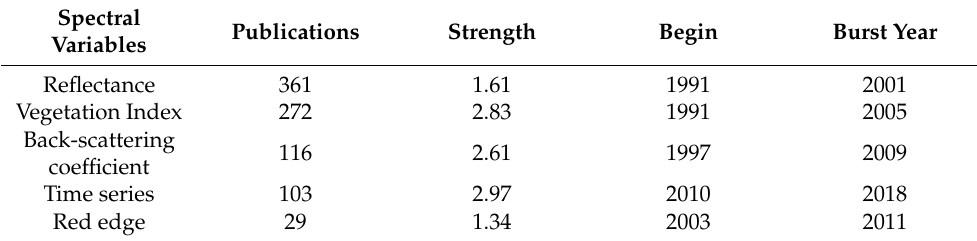
Table 6. The hot spots of rice remote sensing from the perspective of spectral variables.